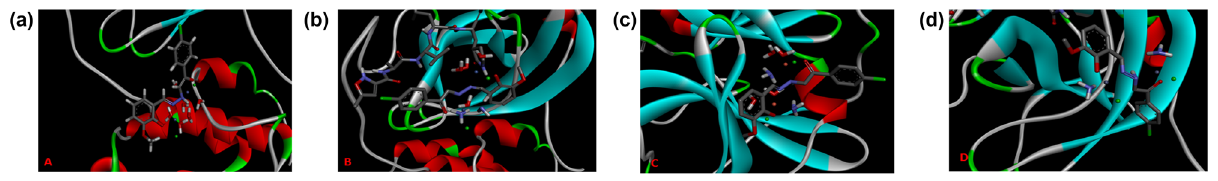
Figure 9: Docking interactions of 6LU7 with a: Co ( II ) , b: Ni ( II ) , c: Cu ( II ) , and d: Zn ( II ) complexes.